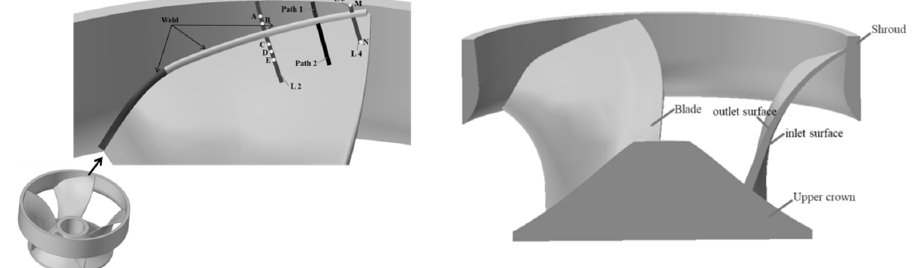
Figure 8. Thermal cycle, stress measurement point and path